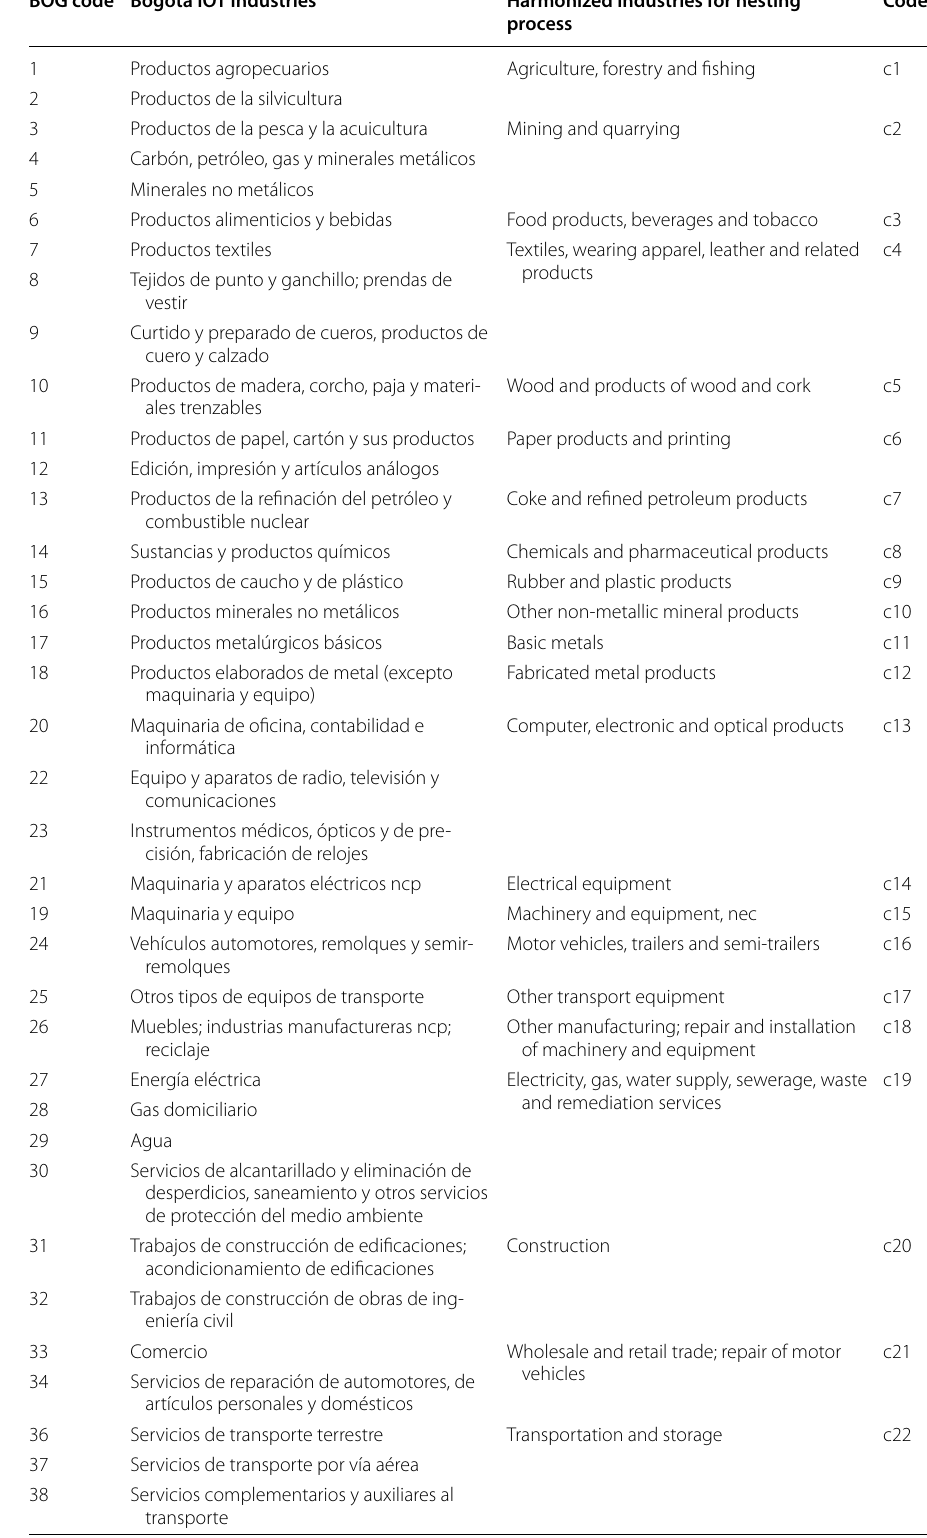
Table 2 Sectorial correspondences for Bogota IOT table. Source: own elaboration BOG code Bogota IOT industries Harmonized industries for nesting process